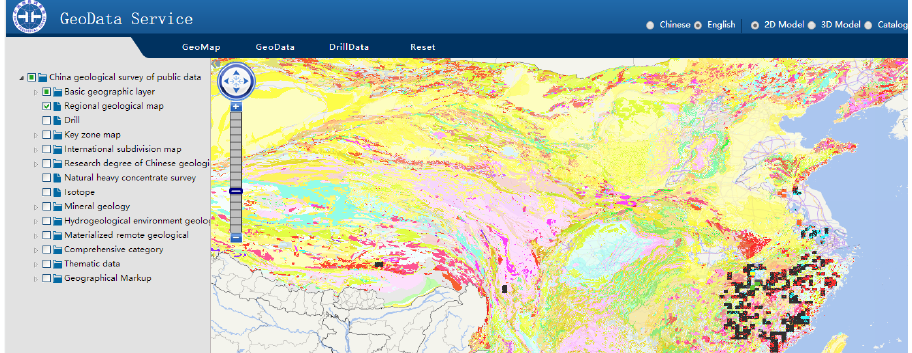
Figure 15. Web portal for the tile map of a China geological survey in the GSI Grid.